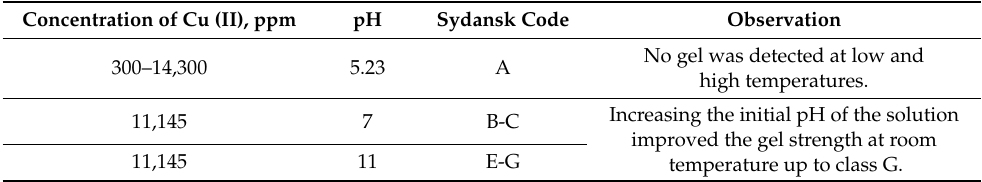
Table 4. E ff ect of pH on the stability of the gel formed by 9 wt.% PaM /